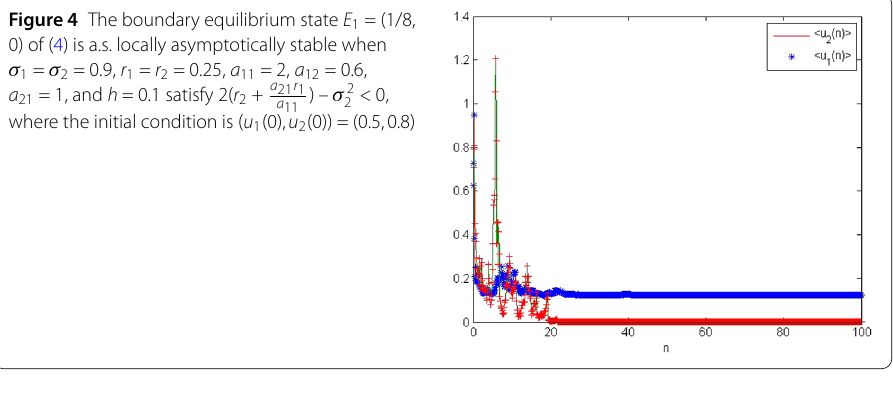
Figure 5 The boundary equilibrium state E 2 = (0, 1/8) of (4) is a.s. locally asymptotically stable